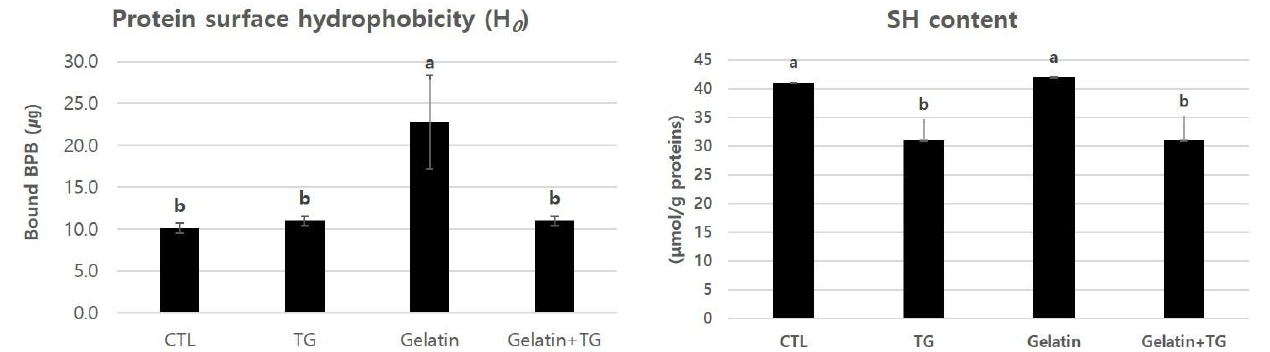
Figure 7. Protein surface hydrophobicity (H 0 ) and the contents of peptides by sulfhydryl (-SH) groups on restructured ham with gelatin and transglutaminase. a,b Means ( n = 3) with the same superscripts in the same row are not different ( p > 0.05).